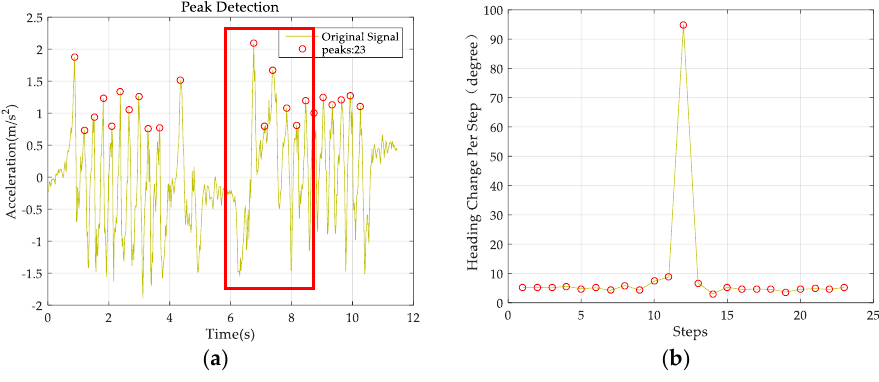
Figure 3. Photo detection. ( a ) The accelerometer reading when taking a photo; ( b ) Heading estimation from the gyroscope when taking a photo.